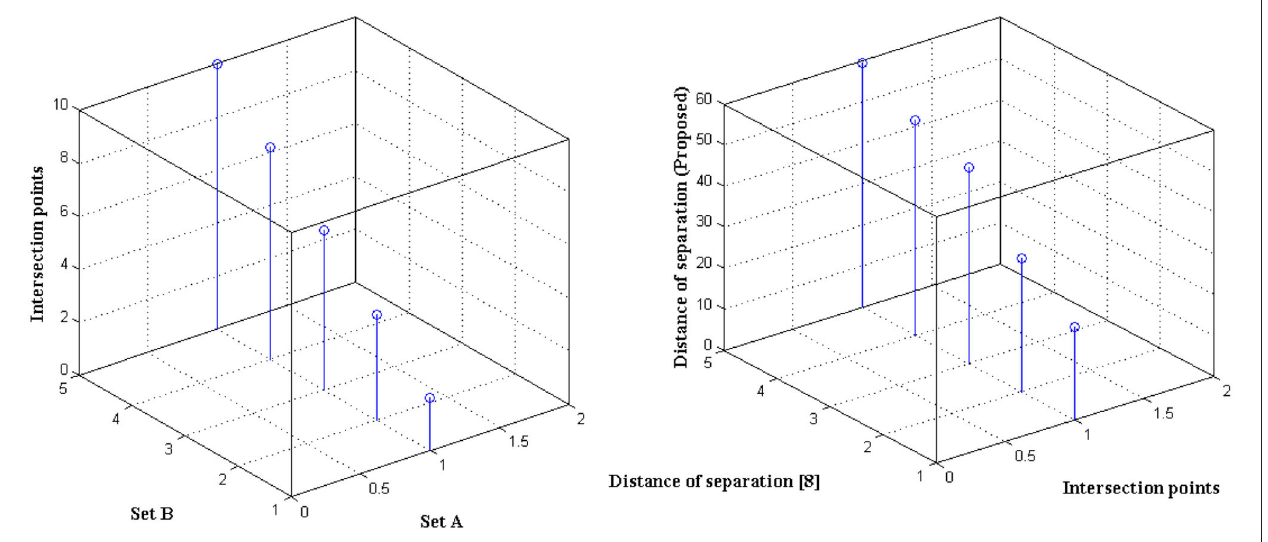
FIGURE 4 | Separation of distance in the incidence of data set.